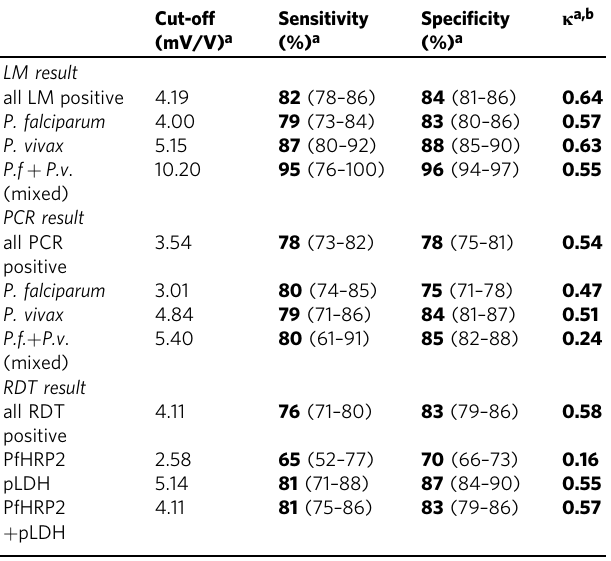
a Bold numbers are the means and numbers in parentheses are the 95% con fi dence intervals b κ is the coef fi cient of agreement according to Landis and Koch 43 .